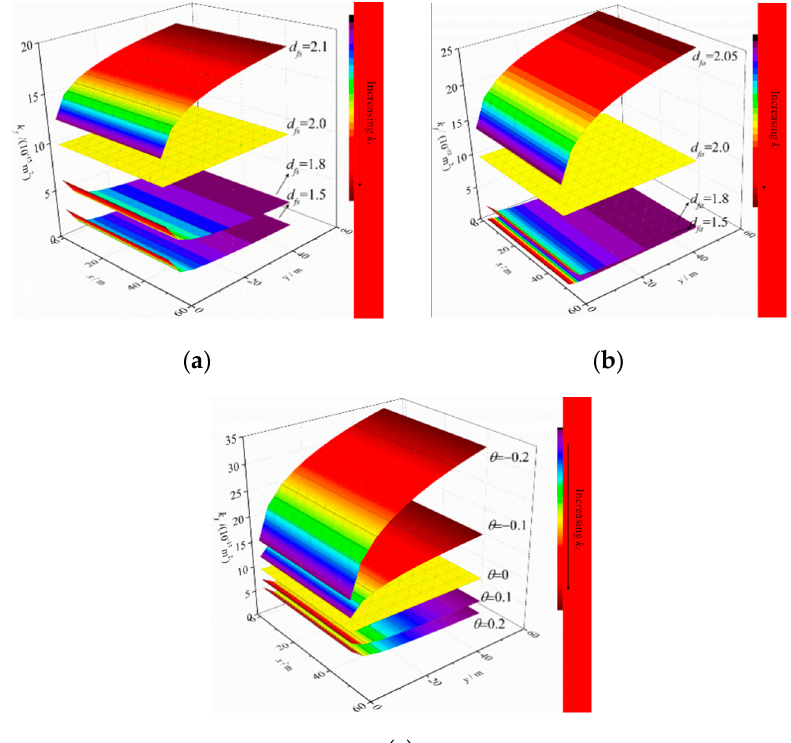
Figure 3. Fracture permeability distribution with different fractal dimensions of induced-fracture spacing and aperture ( d fs and d fa ) and tortuosity index of induced-fracture ( θ ). ( a ) Fracture permeability distribution in SRV with different values of d fs when d fa = 2 and θ = 0; ( b ) fracture permeability distribution in SRV with different values of d fa when d fs = 2 and θ = 0; and ( c ) fracture permeability distribution in SRV with different values of θ when d fs = 2 and d fa = 2.